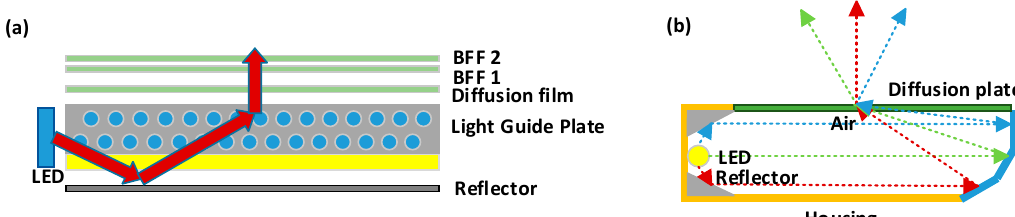
Figure 1. ( a ) Solid light guide module for backlighting applications and ( b ) proposed hollow light guide module for backlighting applications.